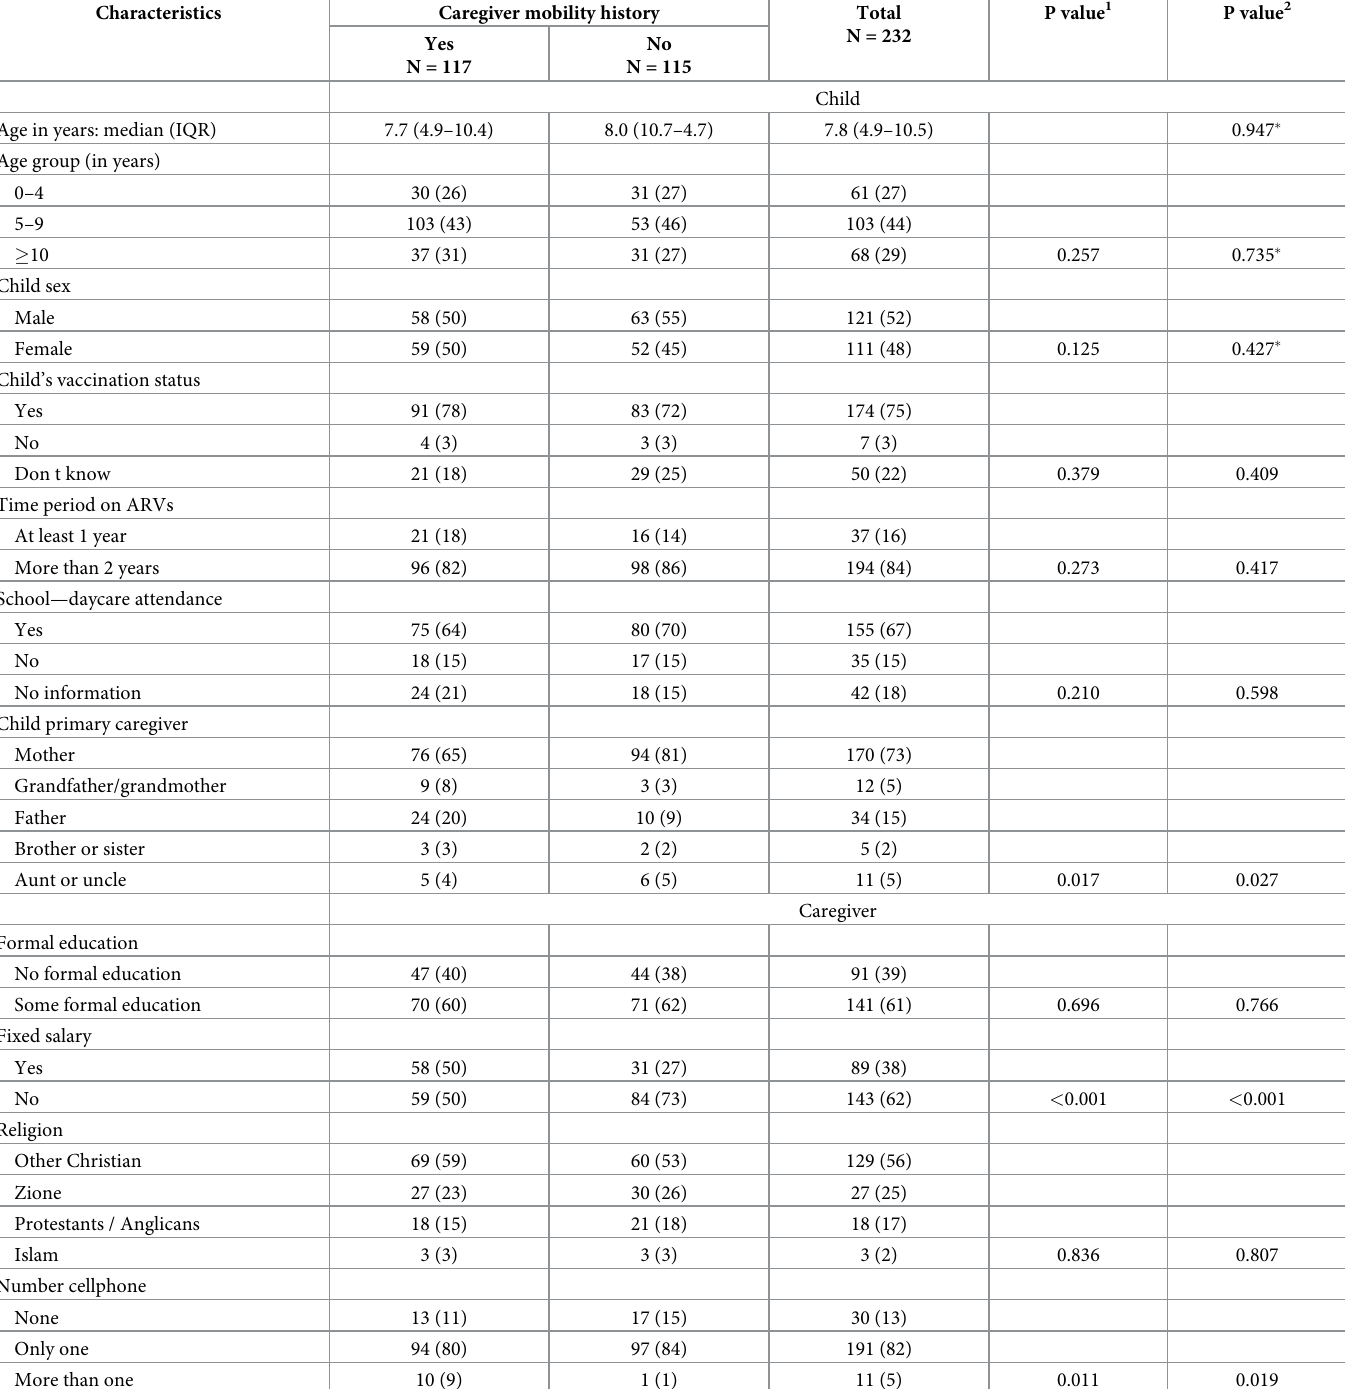
Table 1. Socio-demographic and clinical characteristics of children and their caregivers according to the caregiver’ mobility history at the enrolment, number (percentages).